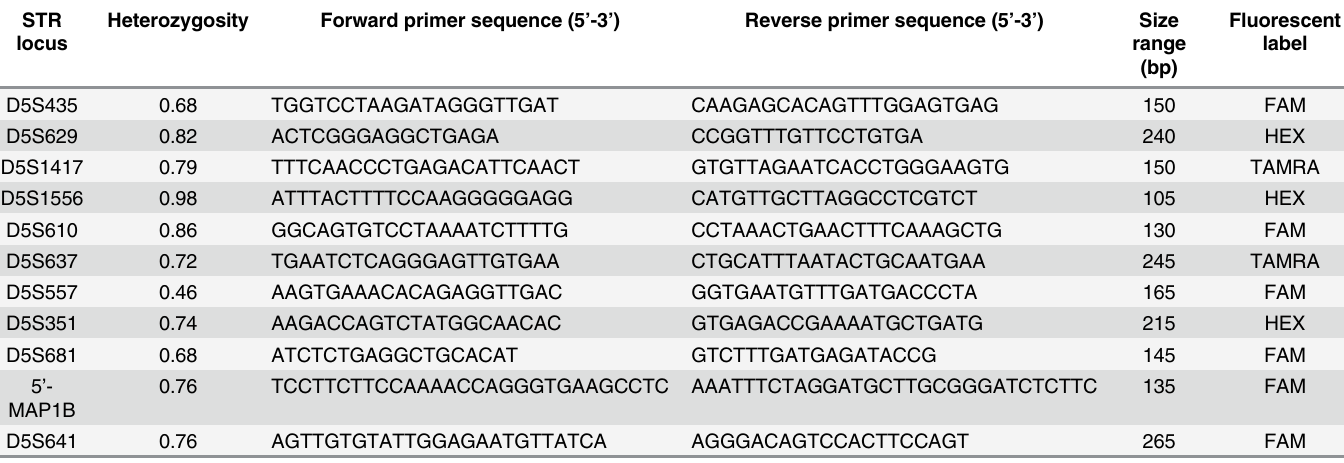
Table 3. The information of STR for SMA.